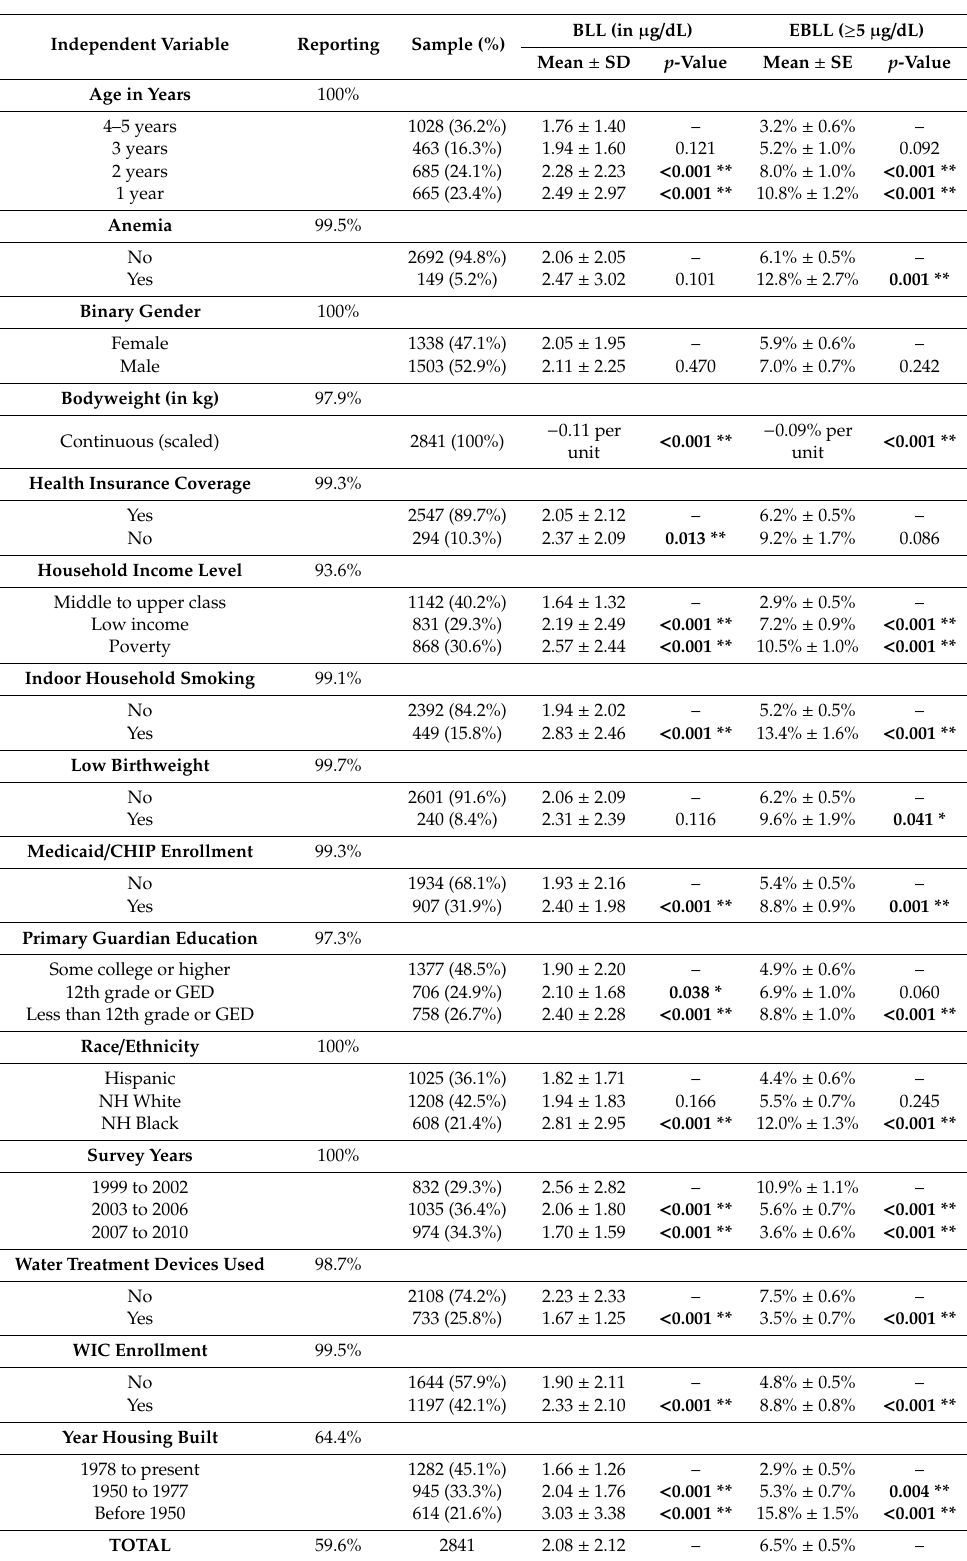
Table 1. Descriptive statistics and simple means for continuous blood lead levels (BLLs) or an elevated BLL (EBLL) ≥ 5 µ g / dL sampled in multiple regression model analysis—the 1999 to 2010